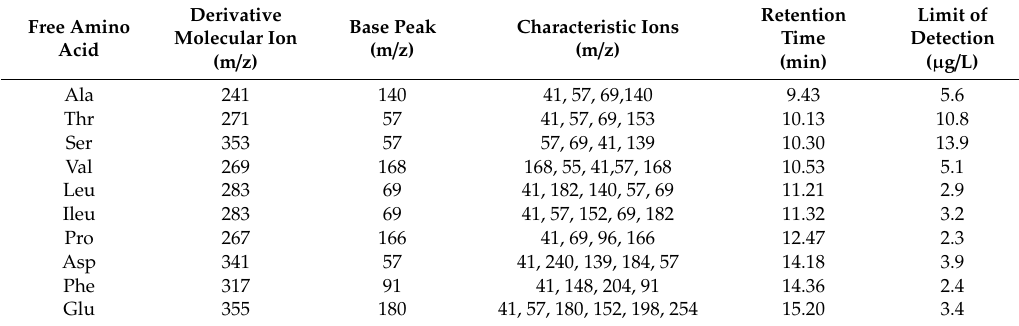
Table 3. Characteristic ions and retention times of FAA derivatives.